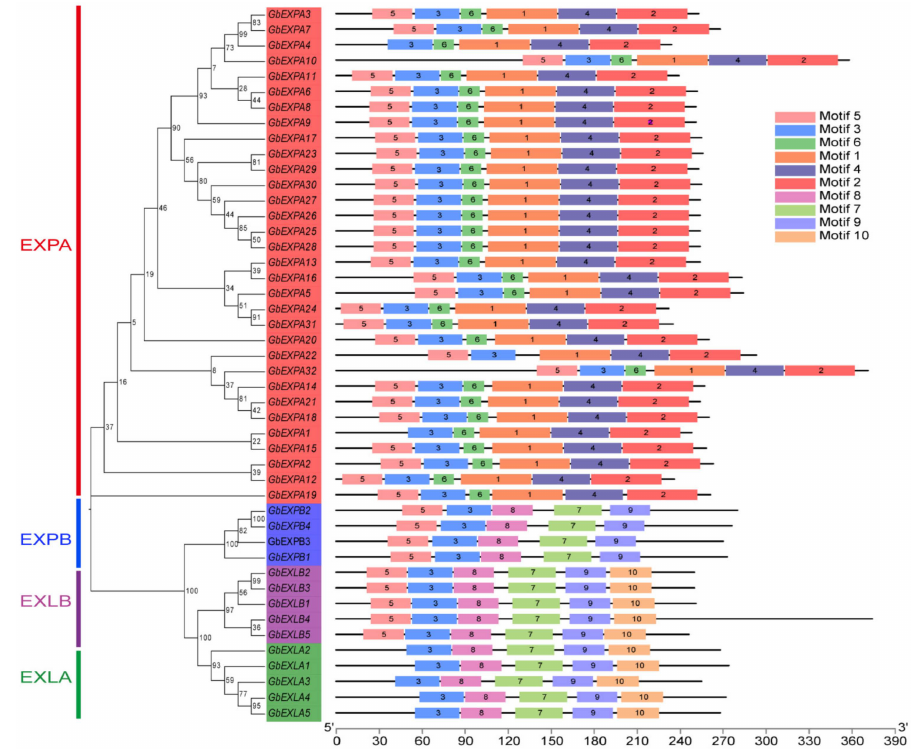
Figure 3. The phylogenetic tree and motif distribution of the GbEXP family.